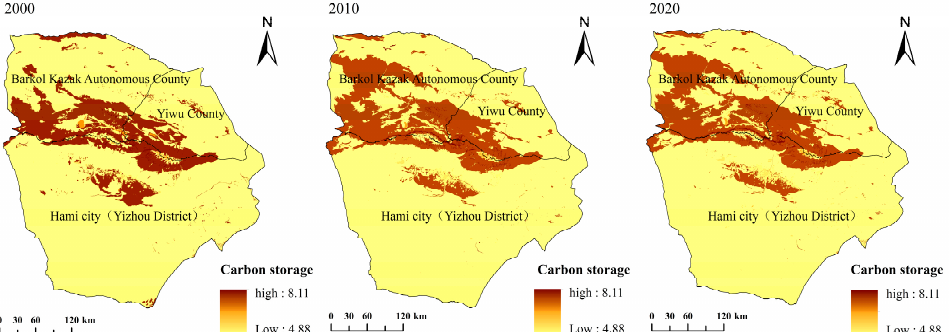
Figure 7. Spatial distribution of the carbon storage in Hami city.